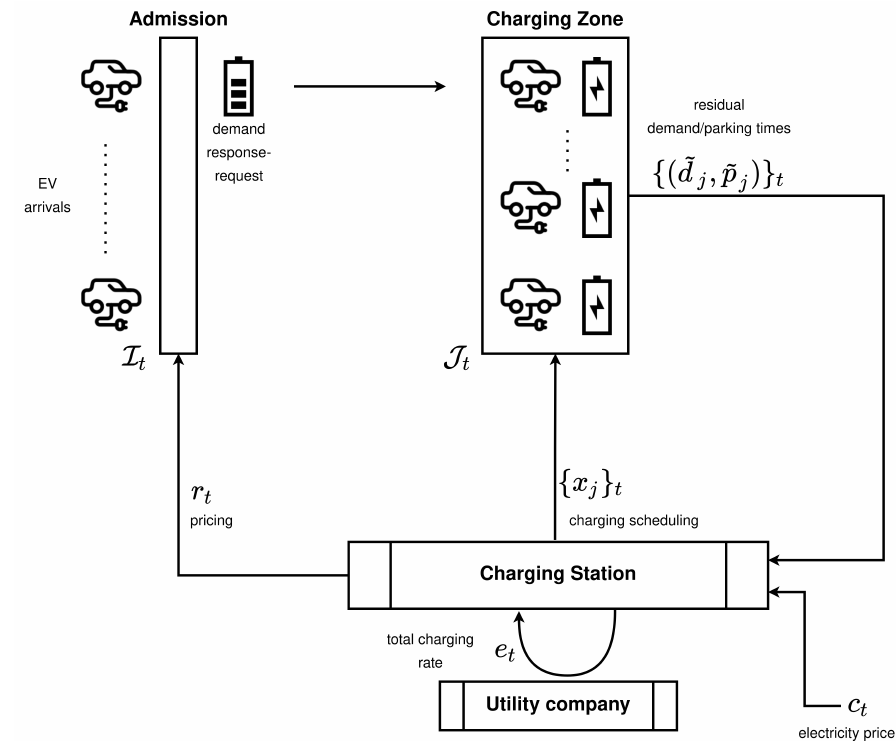
Figure 1. The RL environment for an EV charging station.